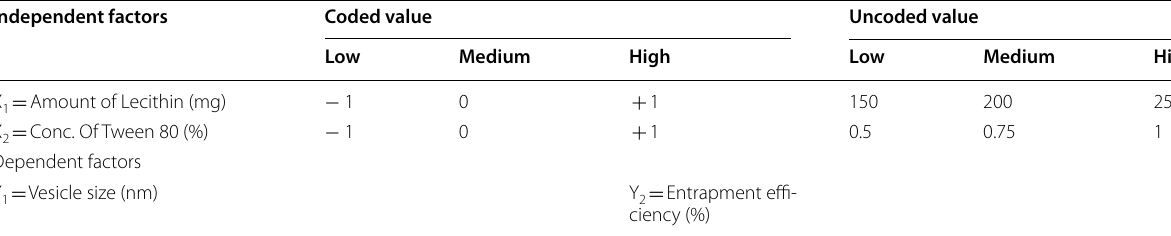
Table 1 Optimization technique with levels and factors Independent factors